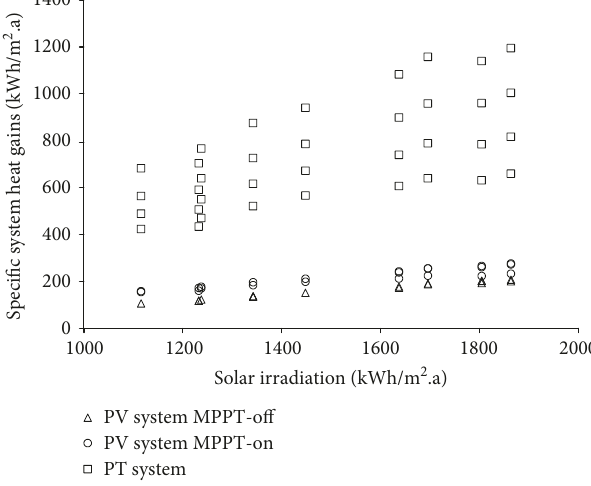
Figure 14: Relationship between speci fi c heat gains and solar irradiation for solar hot water